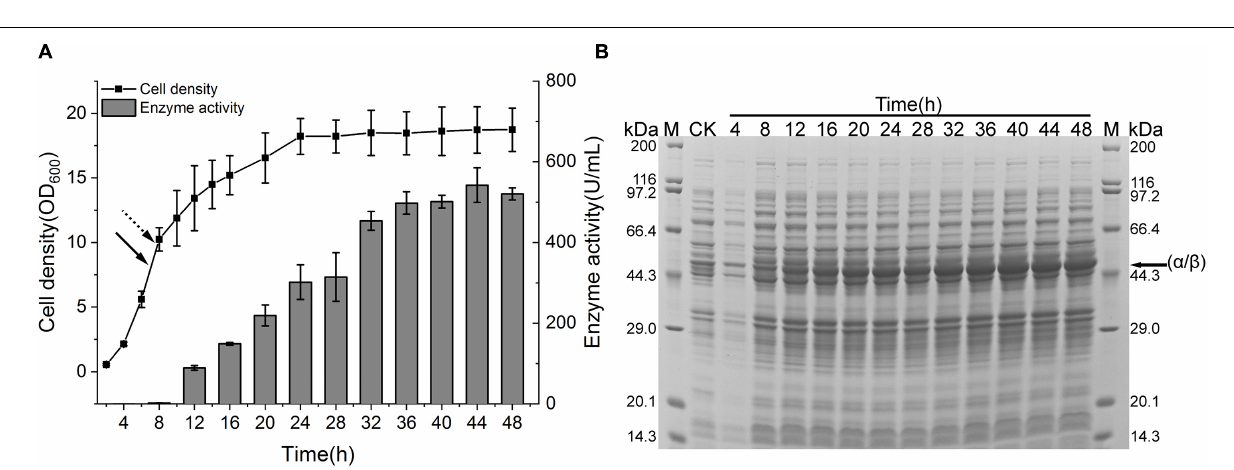
FIGURE 6 | NHase production in a 5-L fermenter. (A) Cell growth and enzyme activity profiles of NHase-producing strain harboring pEVO-(BA)P-NA(HL) in a 5-L fermenter. The solid arrow indicated the start time of fed batch, and the dotted arrow indicated the time of adding Co(II). (B) SDS-PAGE assay of NHase production. CK means the same strain cultured in a test tube containing 2 × YT medium without addition of Co(II). The band of fused α / β subunit was indicated by the